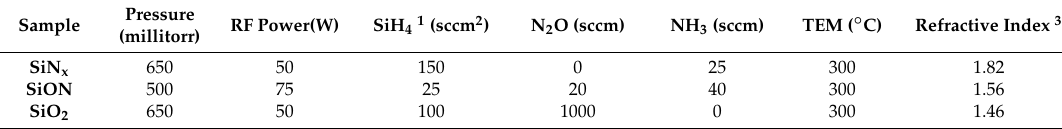
Table 1. Deposition properties of SiN x , SiON, and SiO